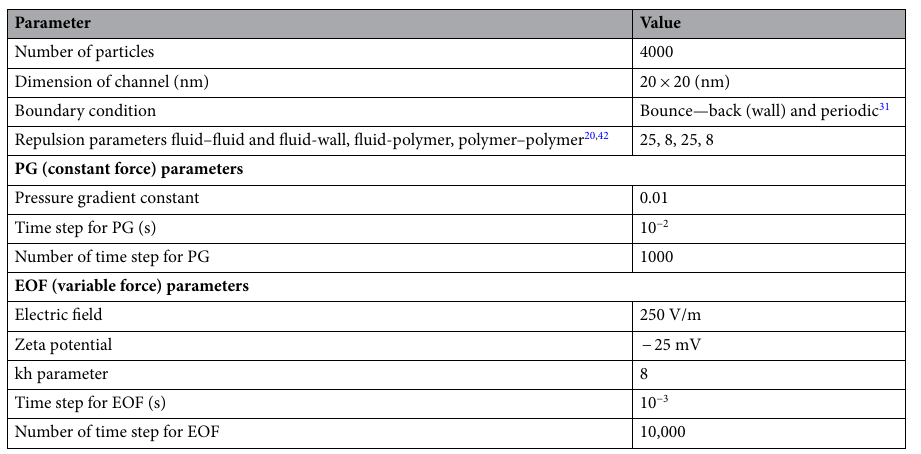
Table 1. Constant values for simulation of nanofluid/polymer motion in the nanochannel.